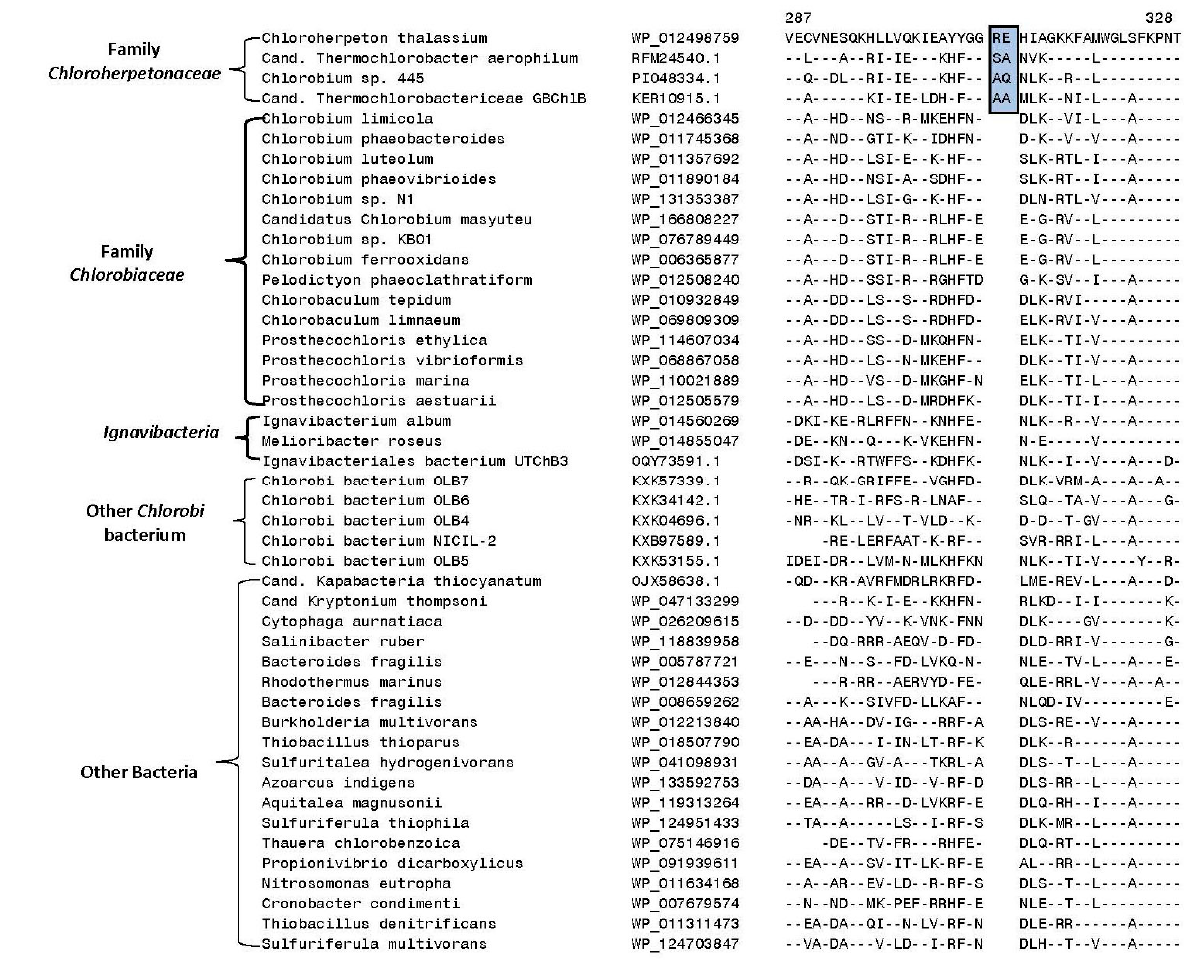
Figure 6 . Partial sequence alignment of the protein UDP-glucose/GDP-mannose dehydrogenase showing a two-amino-acid insertion (boxed) in a conserved region that is exclusively shared by all species/strains that are part of the proposed family Chloroherpetonaceae (Figure 1). This insert is not found in members of the family Chlorobiaceae , class Ignavibacteria , as well as other Candidatus and Chlorobi bacteria strains that do not group with the Chlorobia clade. Sequence information for five other CSIs specific for the family Chloroherpetonaceae is presented in Figures S43–S47 and Table 2.